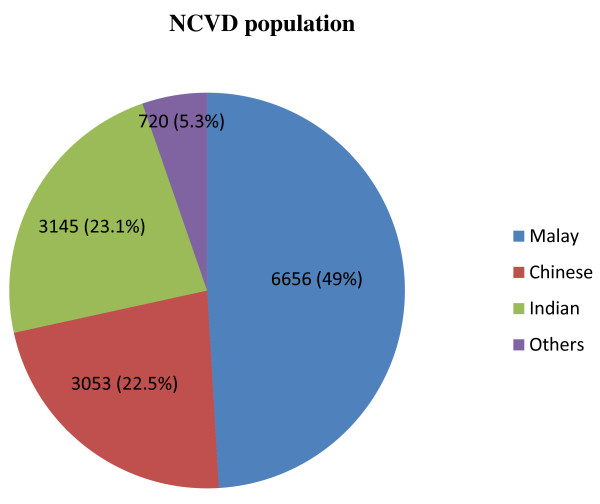
NVCD patients by ethnicity.